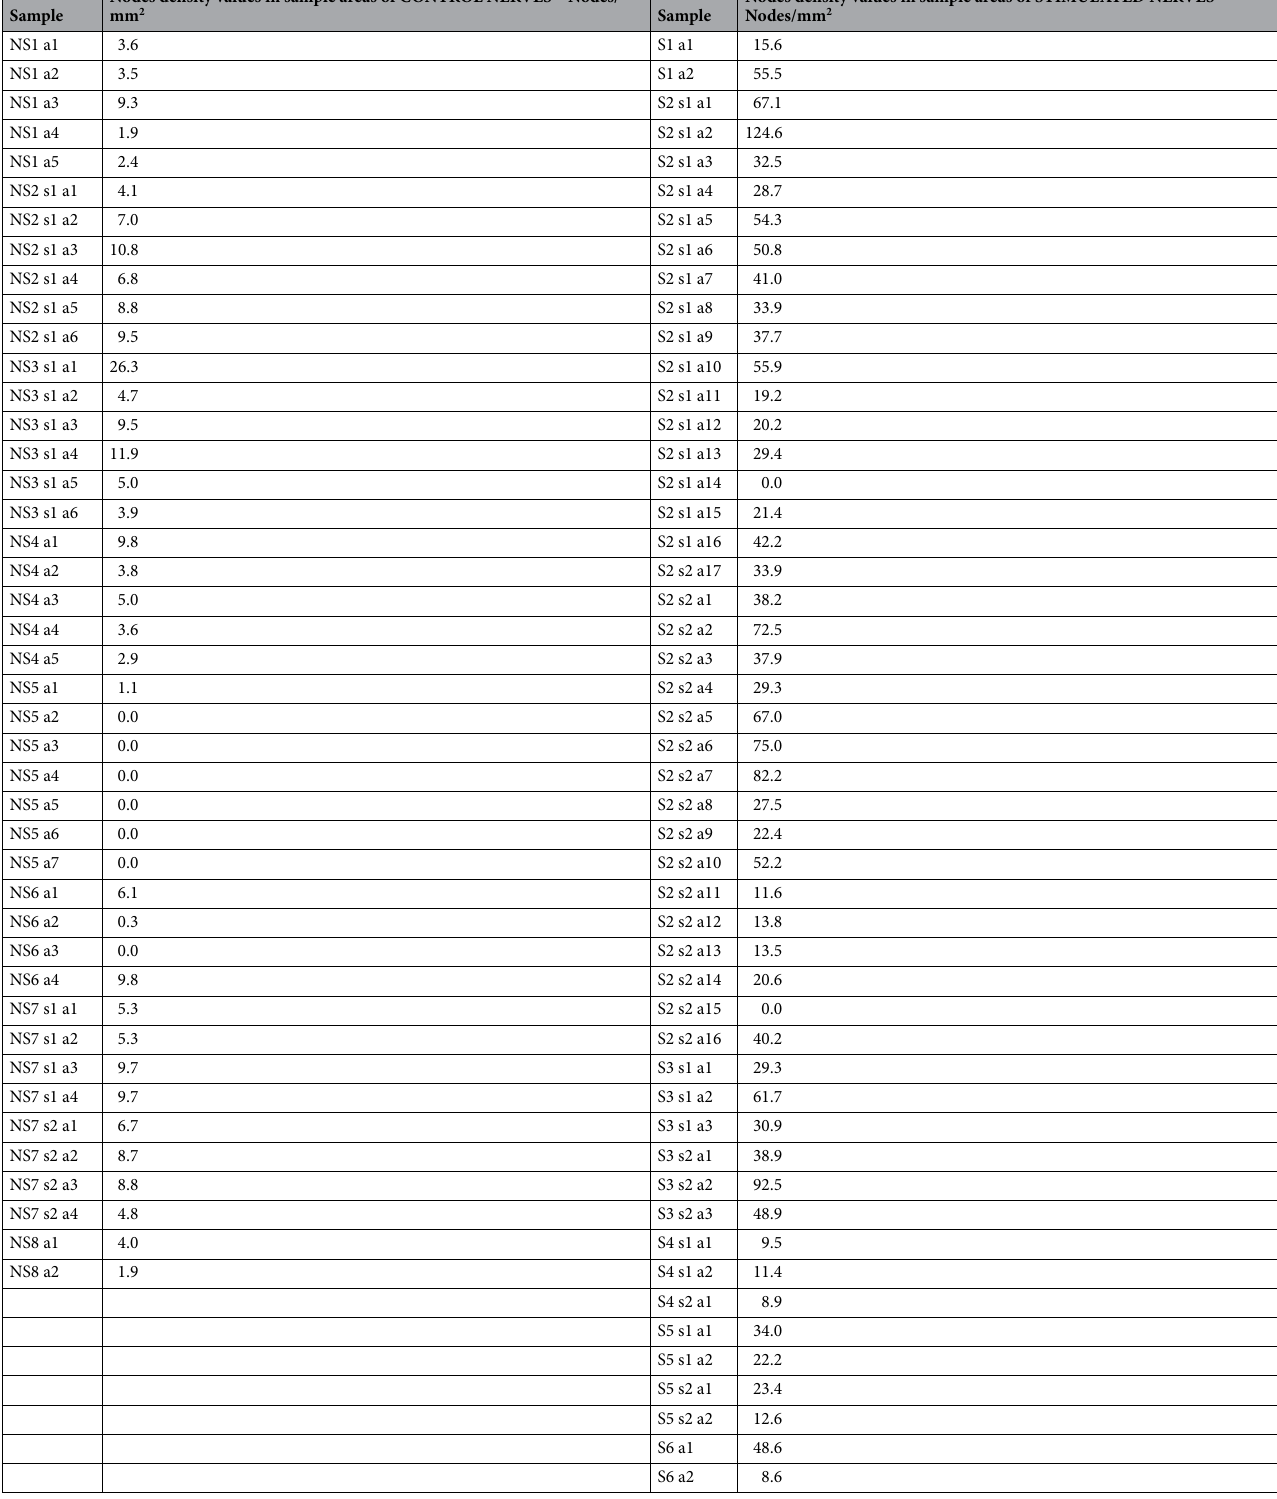
Table 1. Nodes’ density in sample areas in control nerves and nodes’ density in sample areas in stimulated nerves. The values reported below correspond in detail to the Fig. 3 data. NS control nerve, S stimulated nerve, s section, a sample